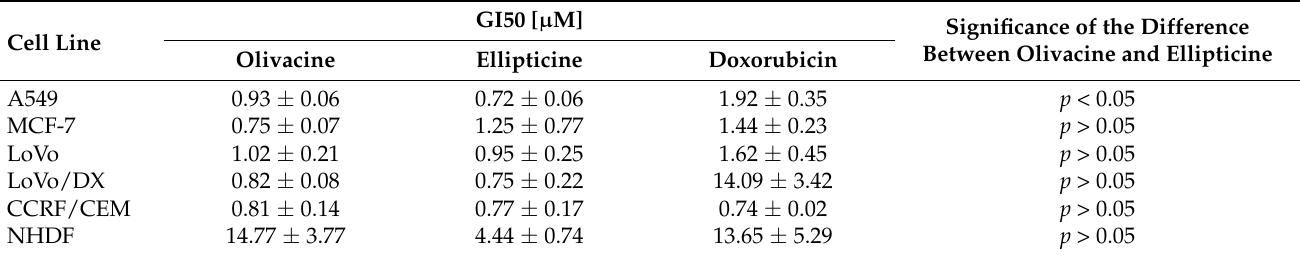
Table 1. SRB assay results (GI 50 values) after treatment with olivacine or ellipticine in A549, MCF-7, LoVo, LoVo/DX, CCRF/CEM, and NHDF